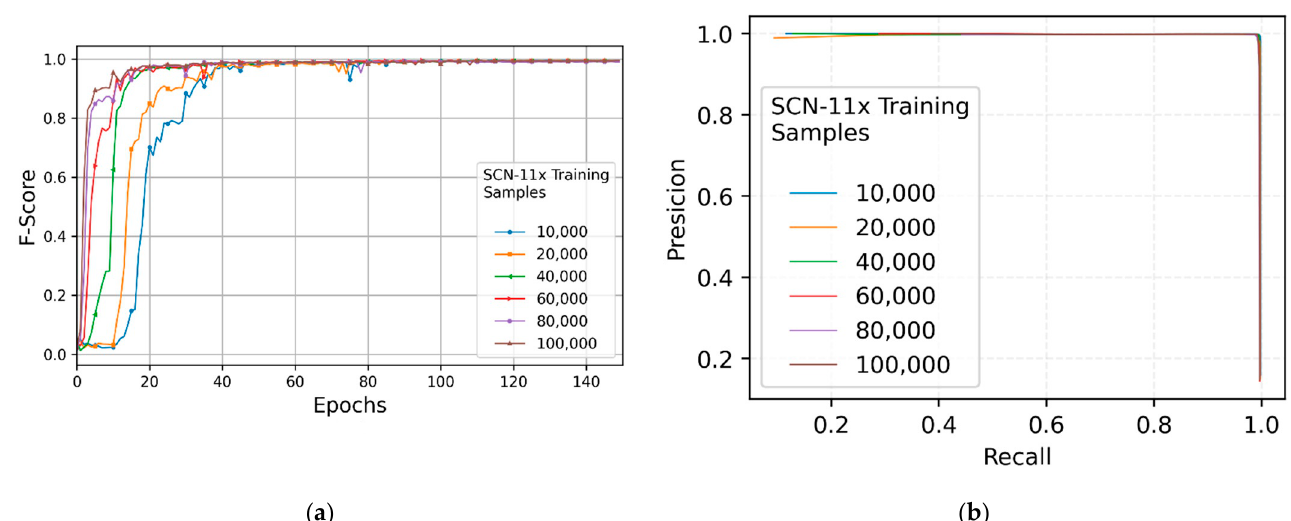
Figure 9. The performance comparison of SCN-11x trained with different numbers of simulation samples. ( a ) F-scores change with training epochs. ( b ) PR curve.